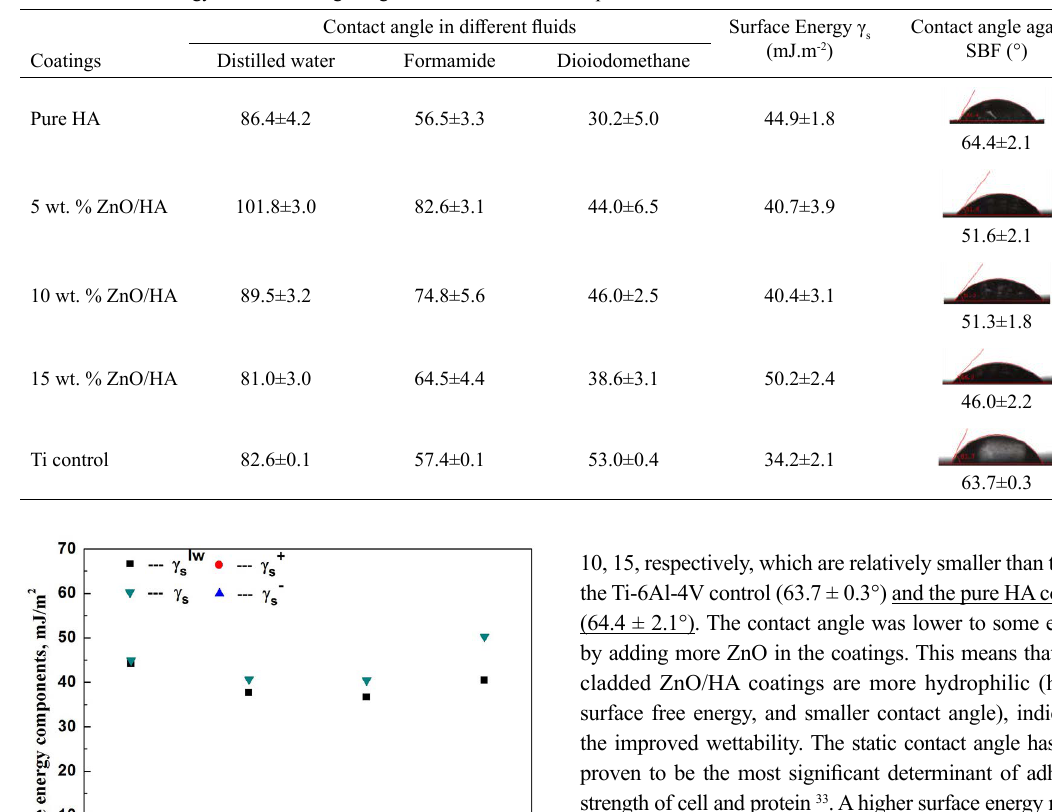
Table 3. Surface energy and contact angles against SBF solution of samples